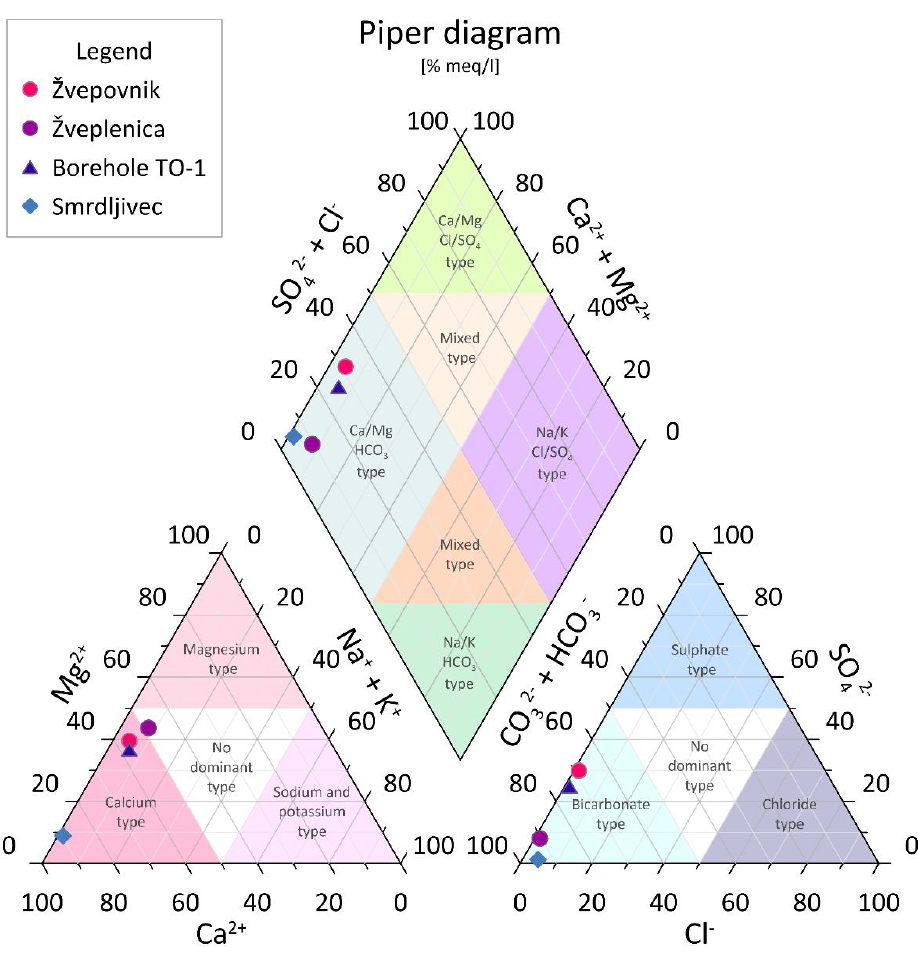
Figure 4. Piper plot diagram of the Žvepovnik spring with geochemical data of the Žveplenica spring [8], Smrdljivec spring [10], and the TO-1 borehole [54].